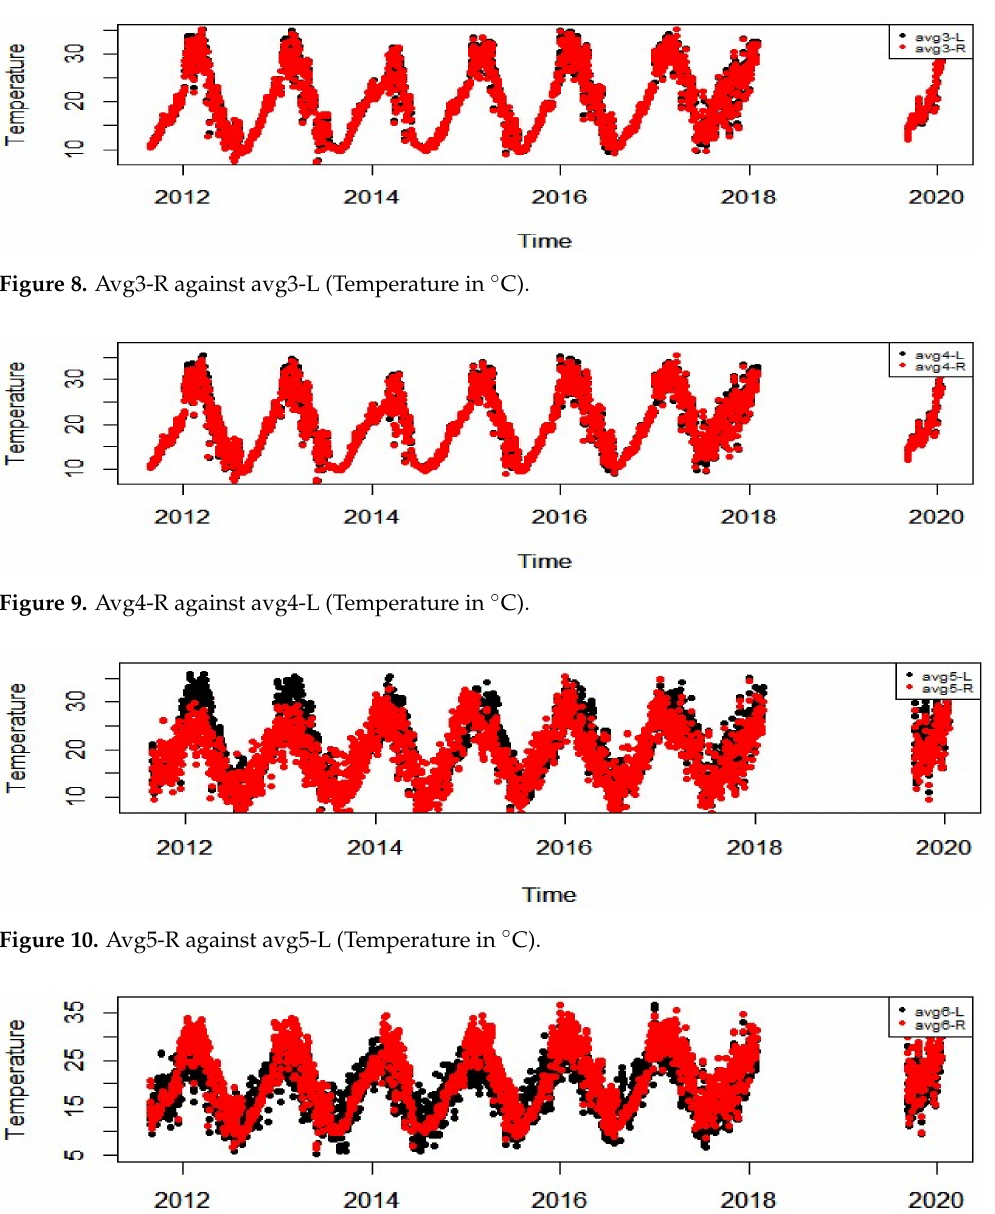
Figure 7. Avg2-R against avg2-L (Temperature in ◦ C).